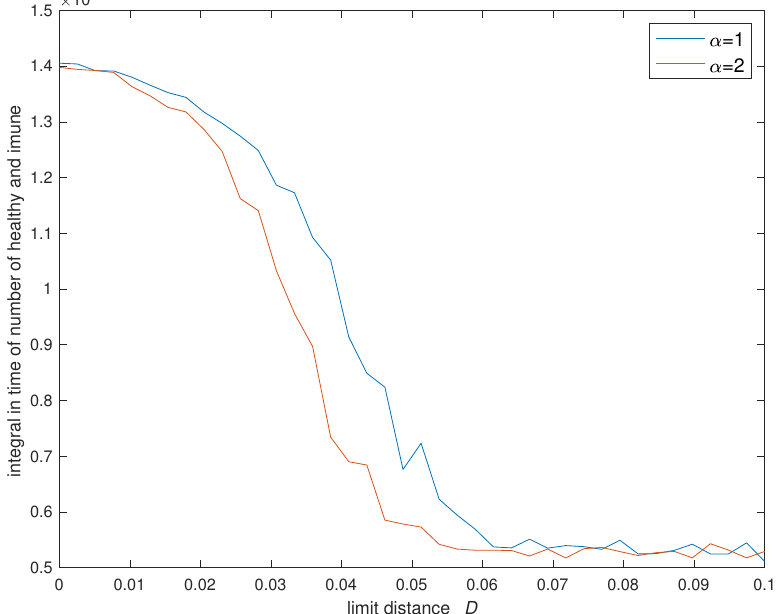
Figure 9. Variation of the integral in time of the number of healthy and ‘immunized’ ( I 4 ) versus the social neighborhood D for α = { 1,2 } ( N = 500, n i = 50, δ = 0.1, p 1 = 0.1, p 2 = 0.9, p 3 = 0.7, p 4 = 0.05, p 5 = 0.02 and N h → ∞